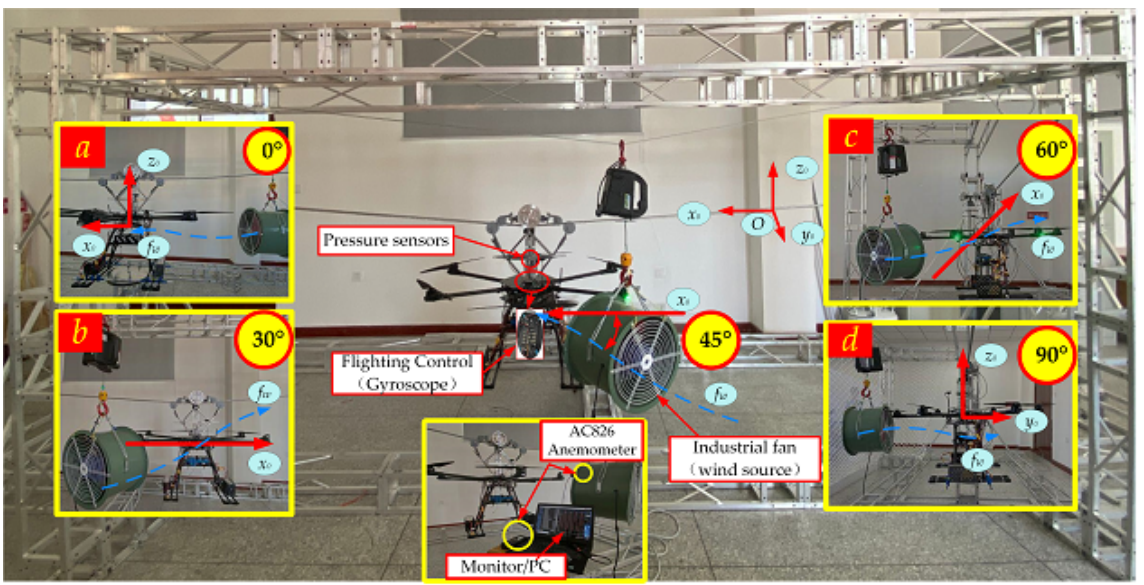
Figure 16. The experimental setup. (a) Position of the fan at a 0 ◦ wind angle. (b) Position of the fan at a 30 ◦ wind angle. (c) Position of the fan at a 60 ◦ wind angle. (d) Position of the fan at a 90 ◦ wind